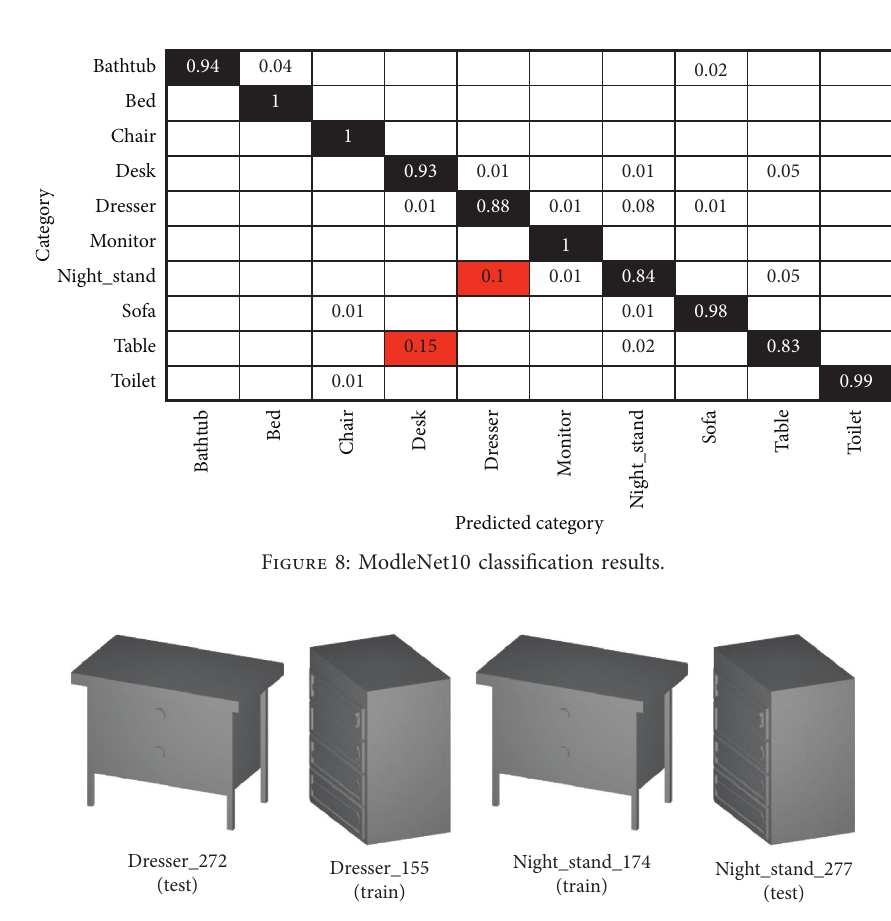
Figure 7: Classification results on